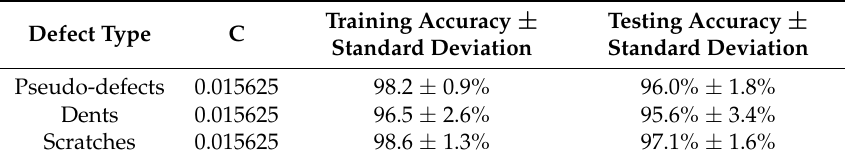
Table 1. Optimal hyperparameters and accuracy for linear kernel.